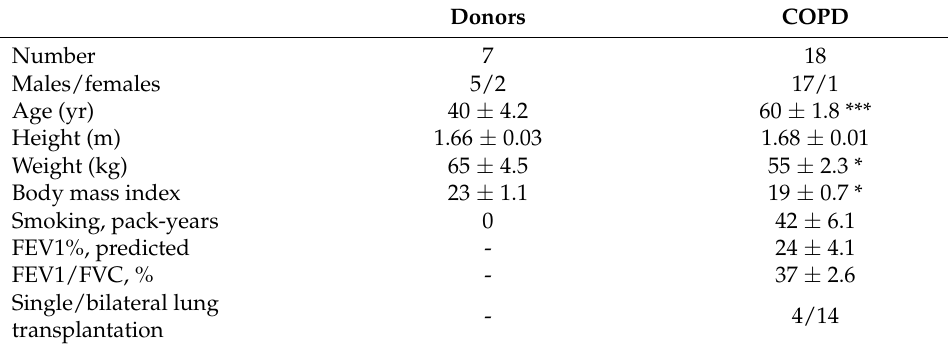
Table 1. Clinical characteristics of donor controls and COPD